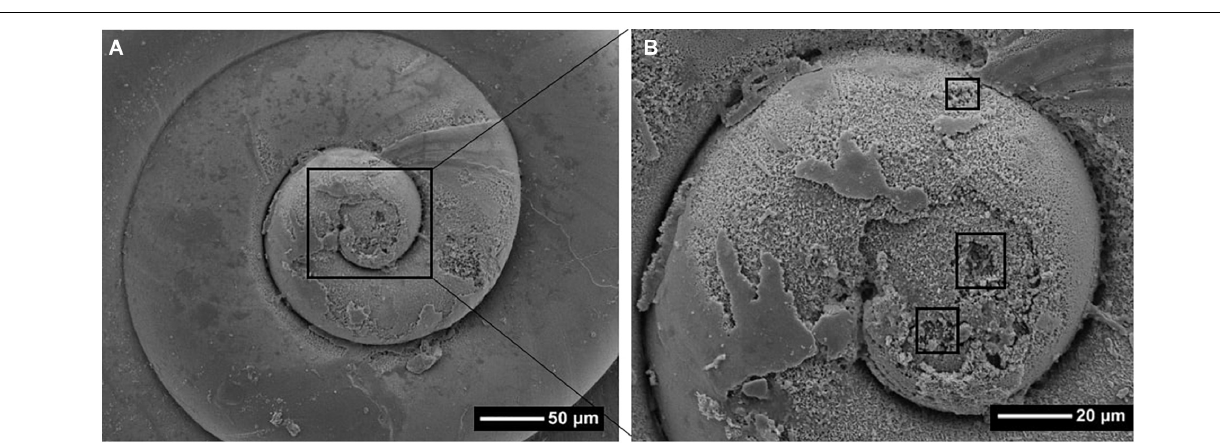
food availability to zooplankton grazers (Tremblay et al.,